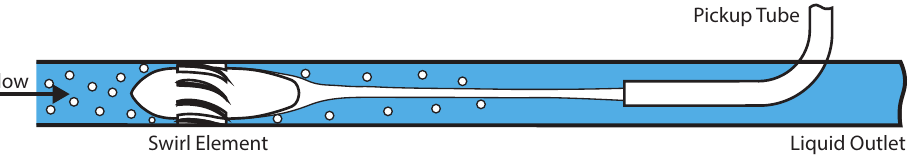
Figure 2. Gas–liquid inline swirl separator. The gas–liquid mixture of the upcoming flow is split into a continuous core of gas and a surrounding annulus of liquid due to the swirl. The separation is performed by the pickup tube, which collects the flow in the center of the separator. Inline swirl separators rely on large centrifugal accelerations (in the order of 100 g) to separate a mixture of fluids of different densities [40]. The flow starts to swirl when the mixture of fluids crosses the swirl element, leading to centripetal forces, which push